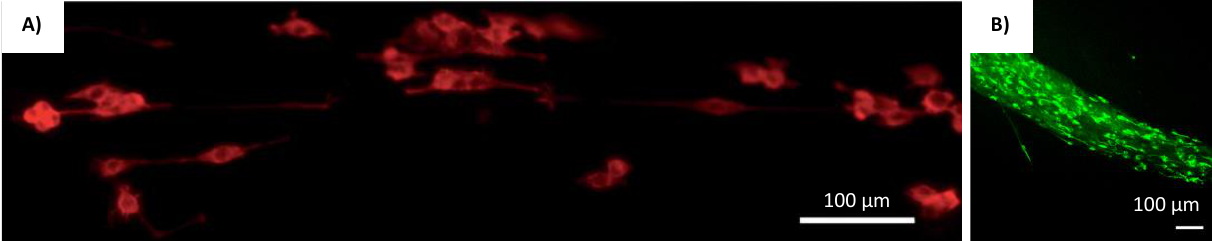
Figure 10. Novel methods for scaffold fabrication. ( a ) The iso-electric focusing procedure. ( b ) Cross- section of the self-assembling Tenacin C peptide.